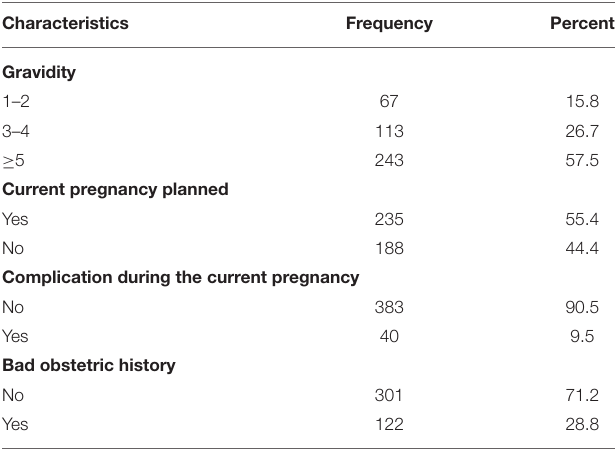
TABLE 3 | Obstetrical related factors of pregnant women in Debremarkos city, northwest Ethiopia. Characteristics